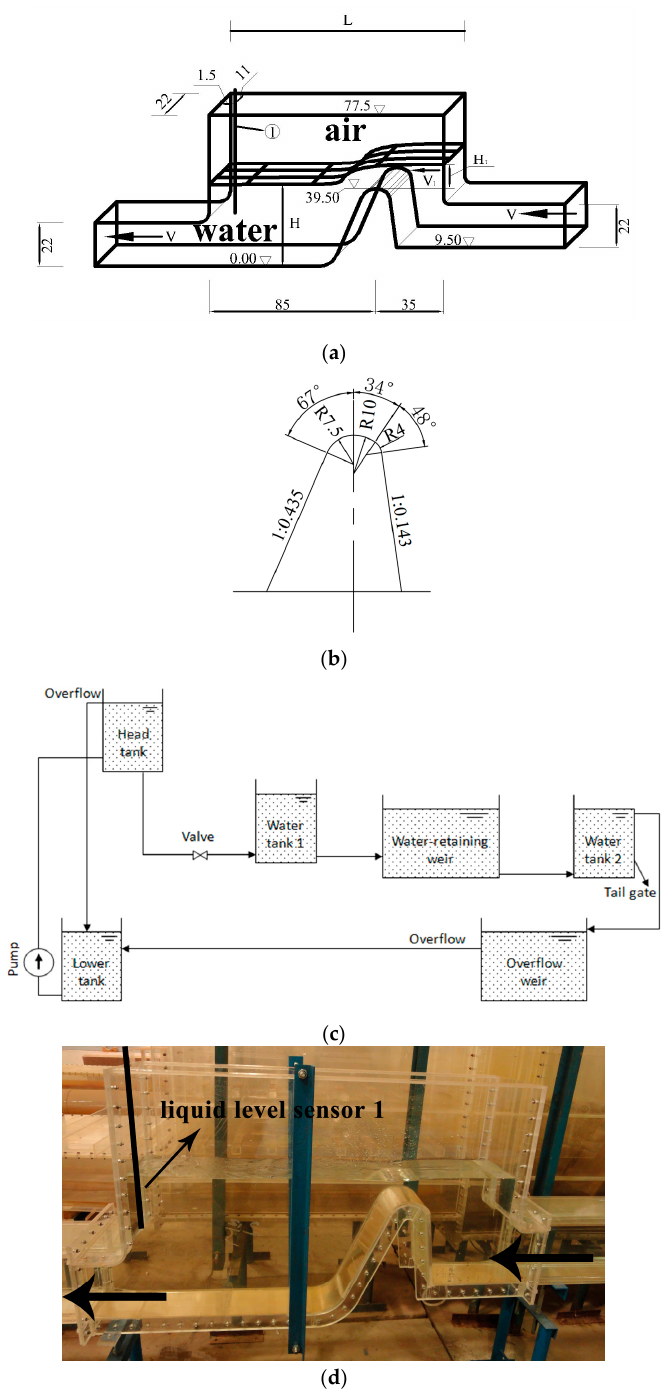
Figure 2. Details of the test tank and the experiment test system: ( a ) Detail drawing of the test tank; ( b ) Detail drawing of the weir (dimensions in cm); ( c ) Schematic diagram of the test loop (dimensions in cm); ( d ) Photo of the experimental model of the test tank.